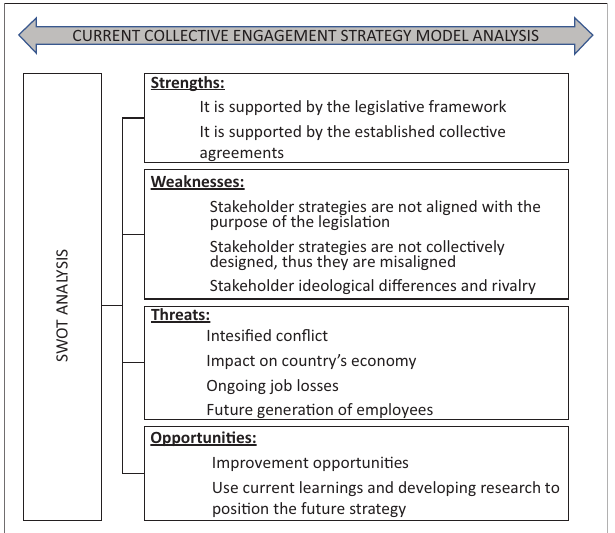
FIGURE 1: Current collective engagement strategy analysis.